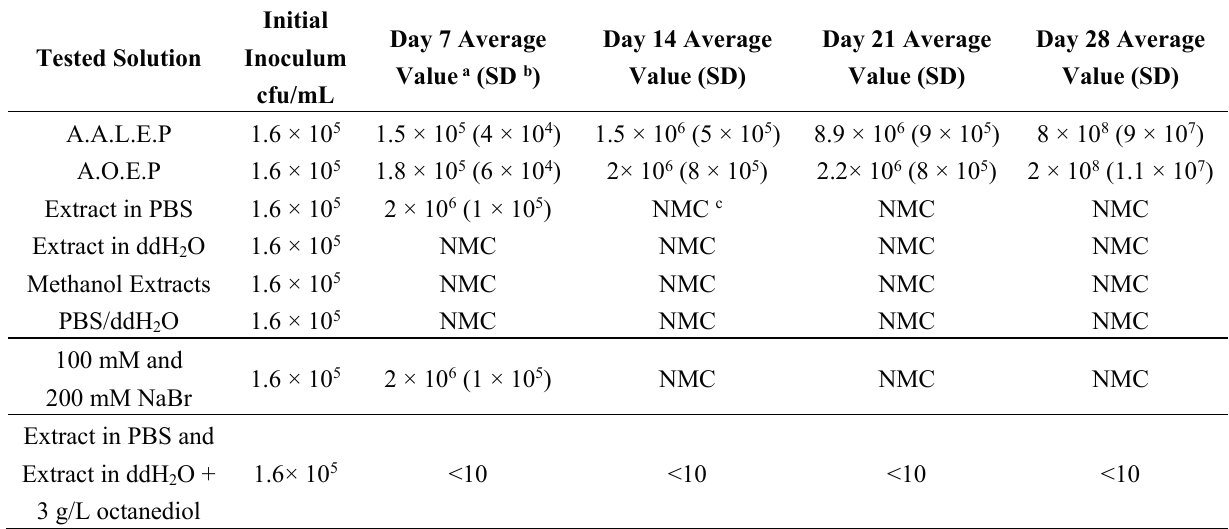
Table 3. Effect of Cornus mas L. extracts against Candida albicans (ATCC